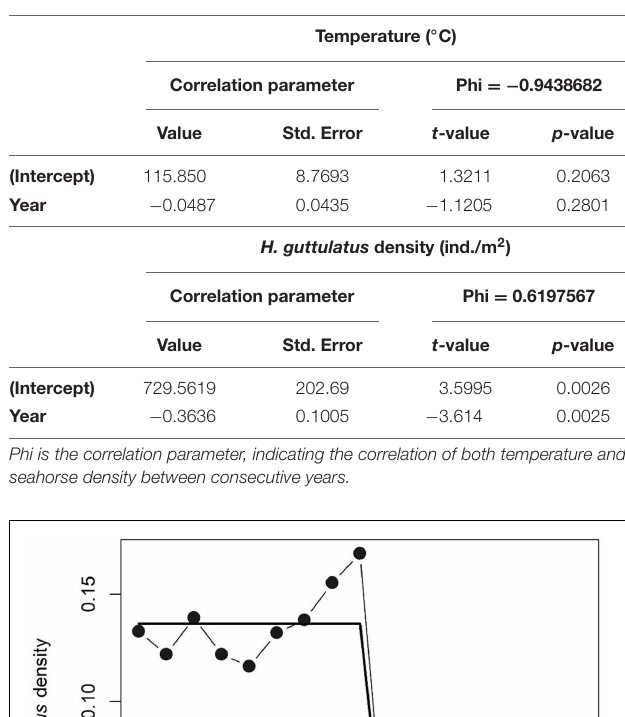
TABLE 1 | Generalized Least Square regression (GLS) results showing no significant trend for temperature and a significant decrease in H. guttulatus density.